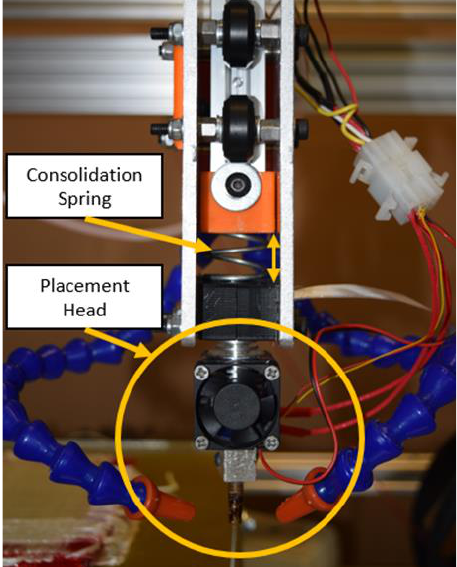
Figure 5. Spring-loaded composite placement end effector.